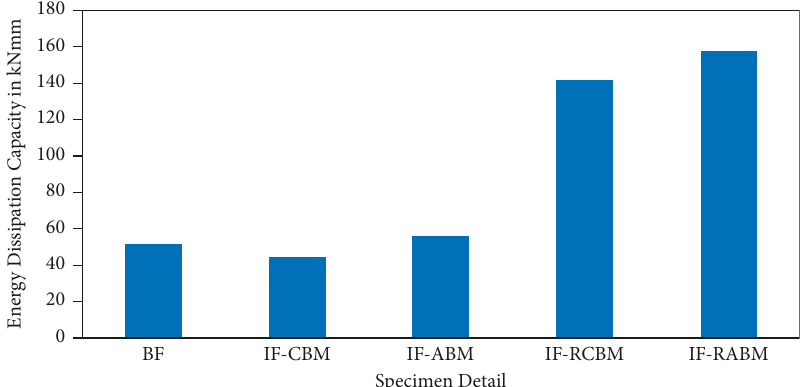
Figure 9: Energy dissipation capacity of specimen.